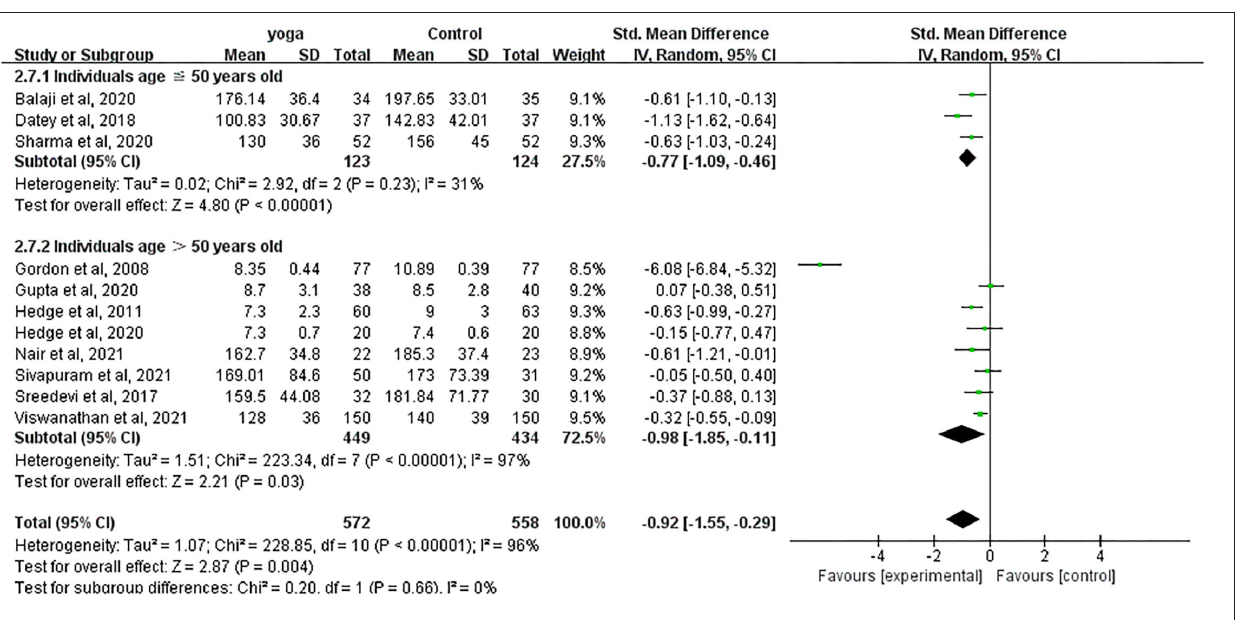
FIGURE 11 | Forest plots of the subgroup analysis on